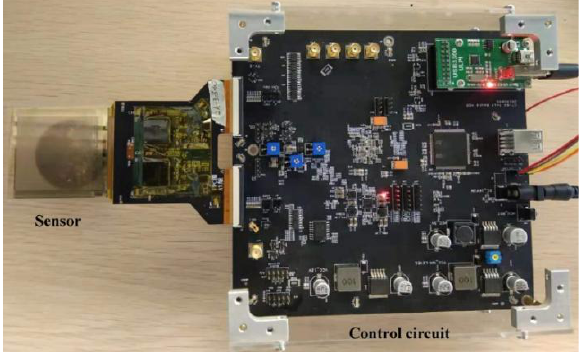
Figure 11. Effect of C 1 and C 2 on the step-up ratio D c2 .